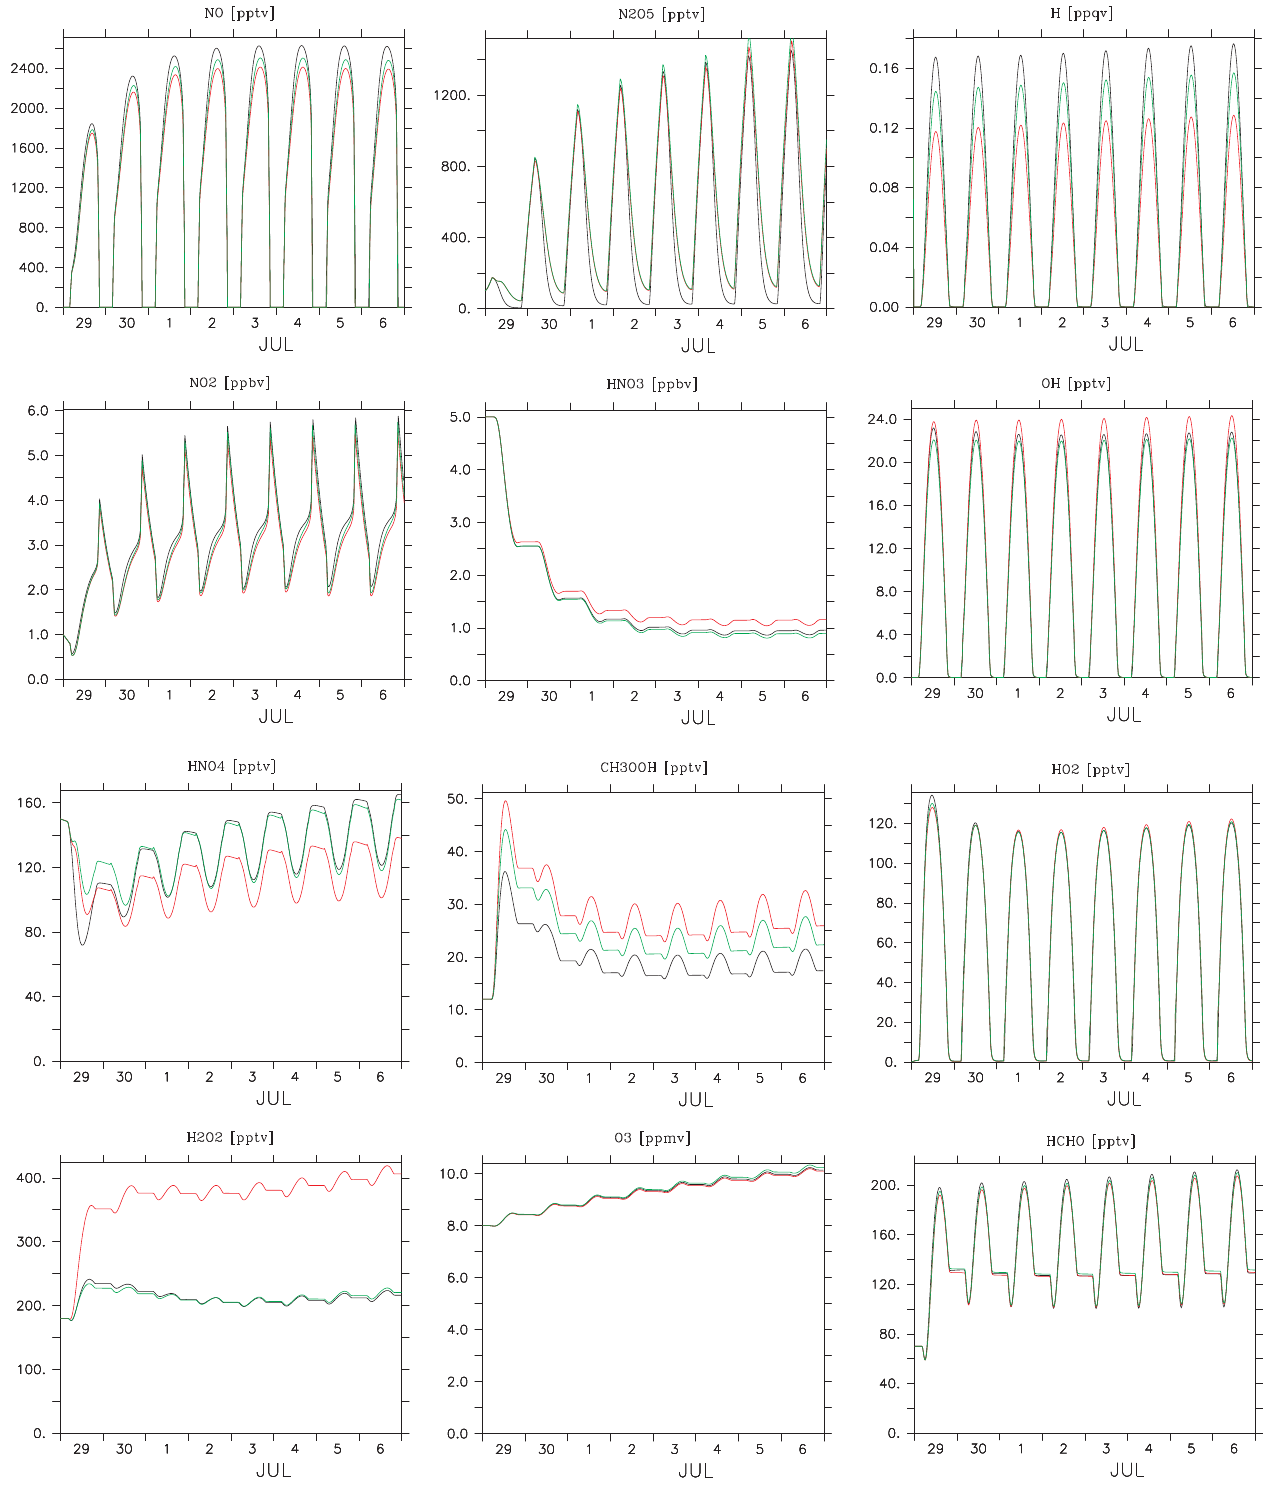
Fig. 1. CAABA box model simulation results with MECCA (black), E4CHEM with original rates (red), and E4CHEM with updated rates (green) for selected